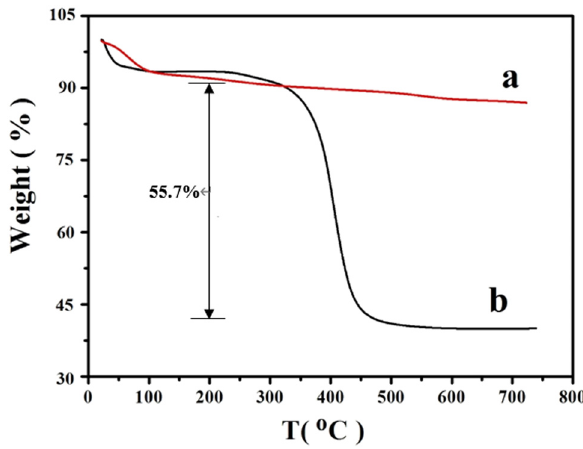
Figure 5: Thermogravimetric curves of ( a ) MSNs and ( b ) MSNs@MIPs.